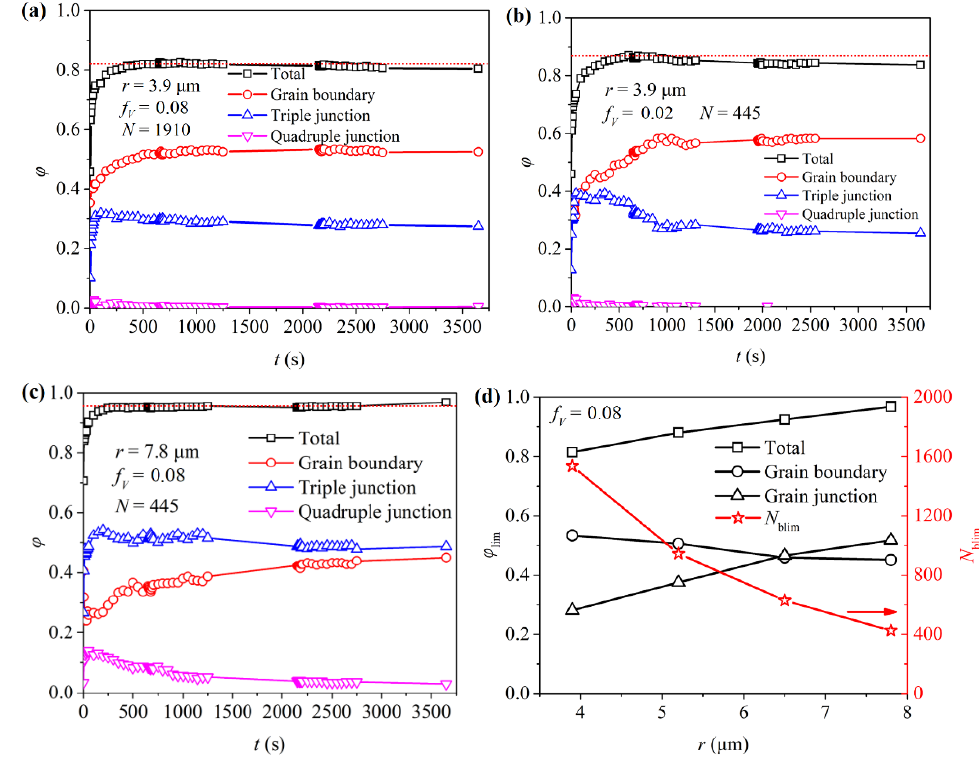
Figure 5. Evolutions of the particle locations during the grain coarsening processes for different simulation conditions. ( a ) r = 3.9 μm, f V = 0.08; ( b ) r = 3.9 μm, f V = 0.02; ( c ) r = 7.8 μm, f V = 0.08; ( d ) The changes of the limiting number fraction ( φ lim ) and the absolute number ( N blim ) of the particles for different particle radii but the same particle area fraction of f V = 0.08.